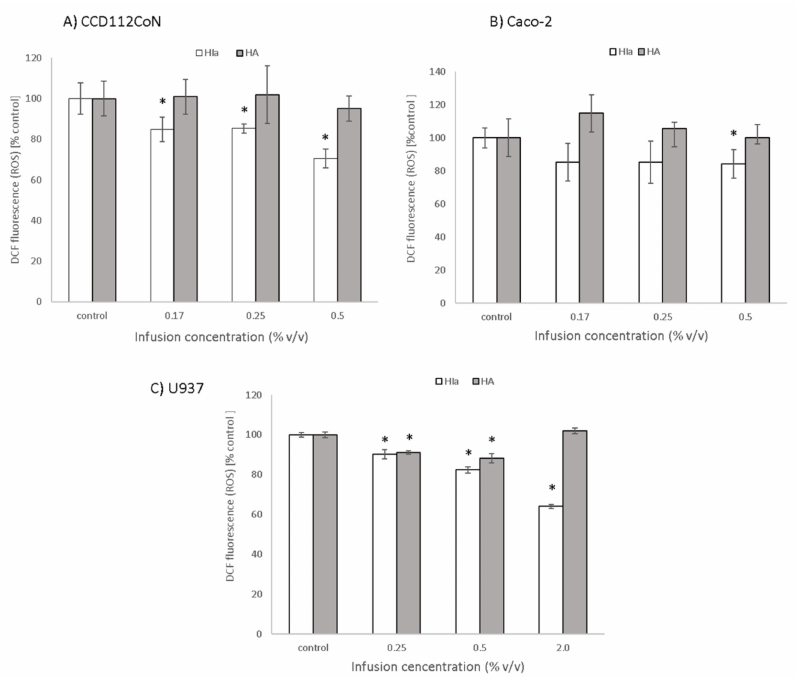
Figure 4. Protective effect of infusions against oxidative stress induction, determined with DCFH-DA assay in ( A ) CCD112CoN, ( B ) Caco-2, and ( C ) U937 cells. The mean ± SD of two separate experiments is presented; * p <